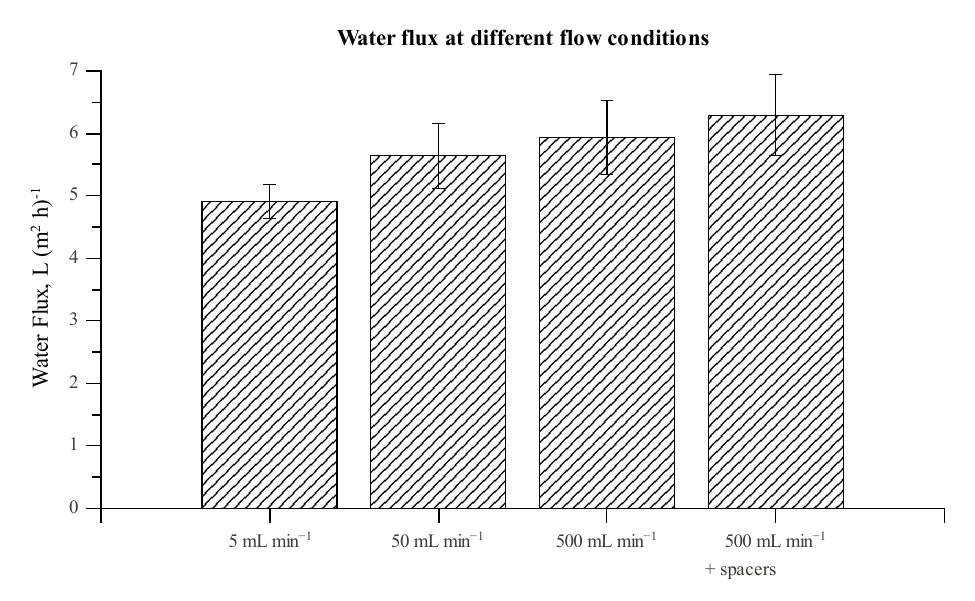
Figure 2. Membrane water fluxes at different cross-flow conditions. Measurements